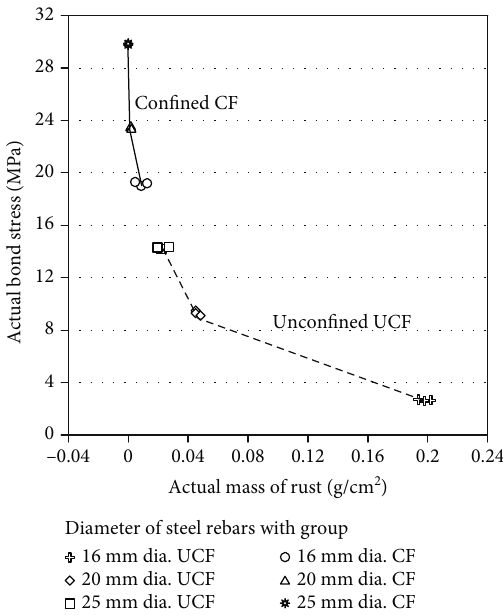
Figure 11: Bond strength and mass of corrosion products.